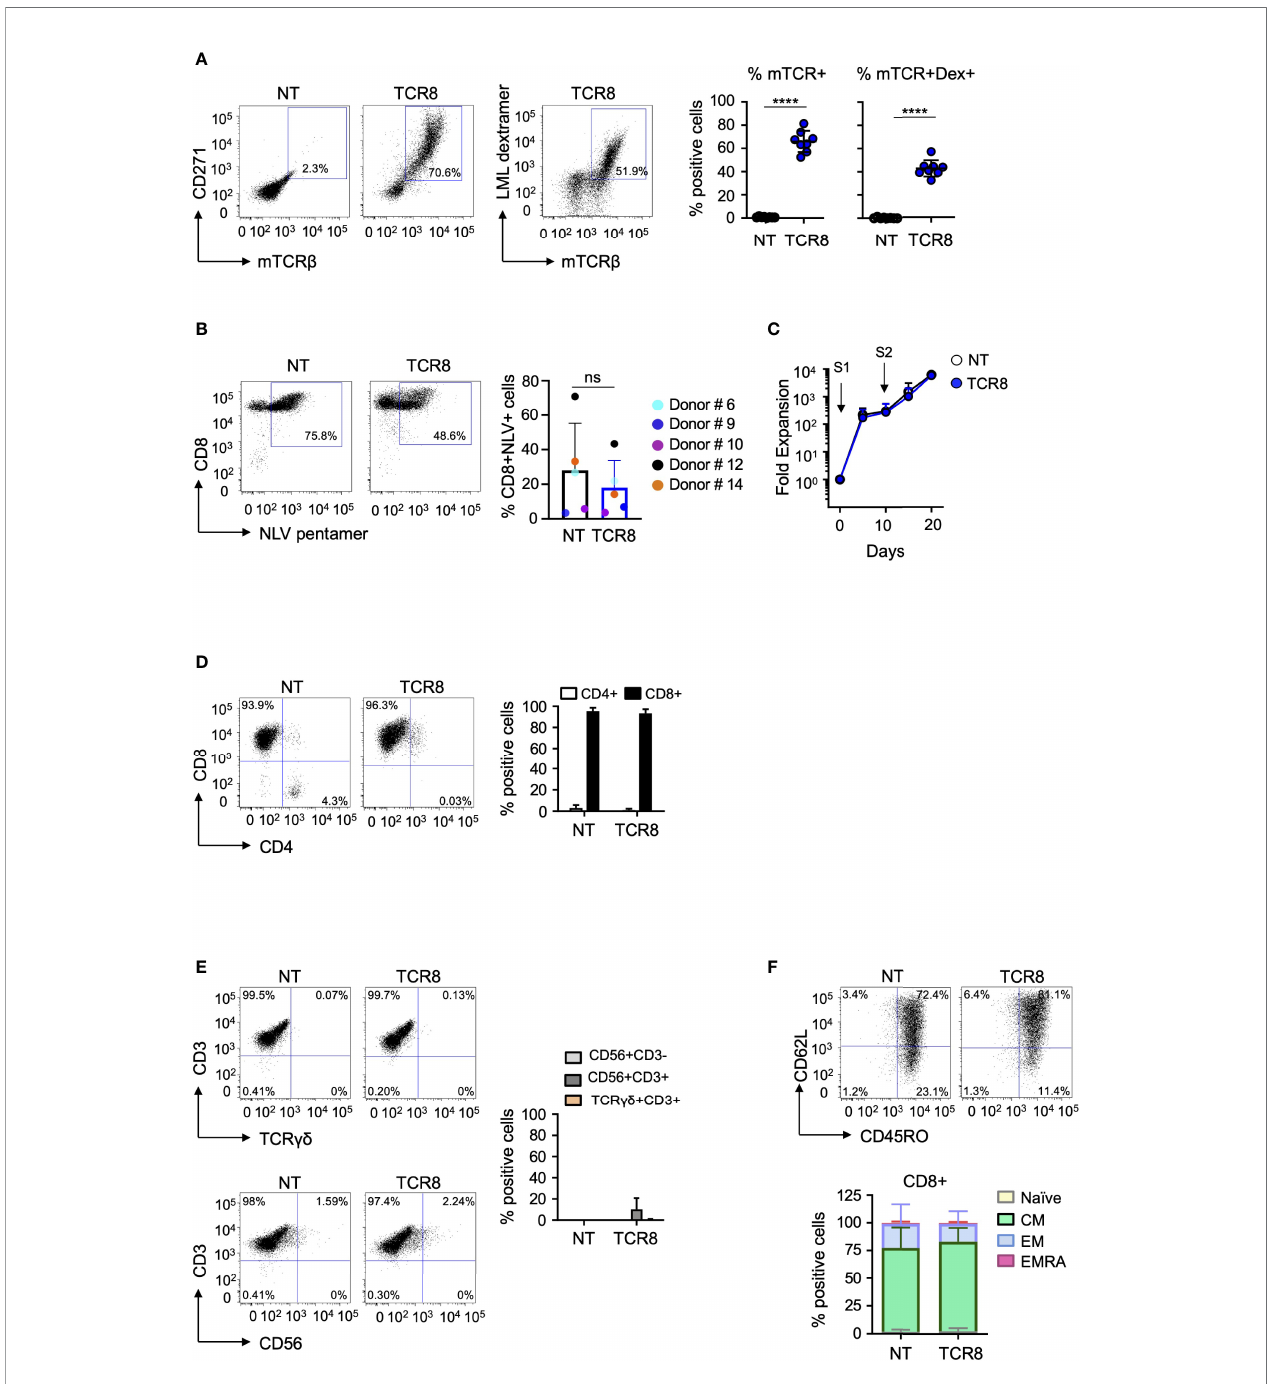
FIGURE 2 | Phenotypic characterization and fold expansion of TCR8+ VSTs. (A) Representative FACS plots (left) and summary (right) of transduction ef fi ciencies (mTCR b , CD271) and transgenic TCR speci fi city [LML dextramer (Dex)]. NT: non-transduced. NT vs TCR8+, mean ± SD, ****p <0.0001, n=8 in both. (B) Representative FACS plots (left) and summary (right) of CMV-speci fi c T cells in NT and TCR8+ VSTs. NT vs TCR8+, mean ± SD, n=5, p=ns. Dot color indicates individual donors. (C) Fold expansion of NT (open circles) and TCR8+ (blue circles) VSTs after fi rst (S1) and second (S2) stimulation. (D) Distribution of CD4+ and CD8+ T cells, representative FACS plots (left) and summary (right) (gated on total live cells), mean ± SD, n=5. (E) Analysis of NK cells (CD56+CD3-), activated T cells (CD56+CD3+), or TCR gd T cells (TCR gd +CD3+) in NT and TCR8+ VSTs. Representative FACS plots (left) and summary (right) (gated on total live cells), mean ± SD, n=5. (F) Representative FACS plot (top) and summary (bottom) (gated on live CD3+CD8+ T cells) of memory phenotype of VSTs: naïve (T N ), central memory (T CM ), effector memory (T EM ) and terminally differentiated (T EMRA ) subsets characterized in NT and TCR8+ VSTs based on CD45RO and CD62L staining, n=5, mean ± SD. ns, not signi fi